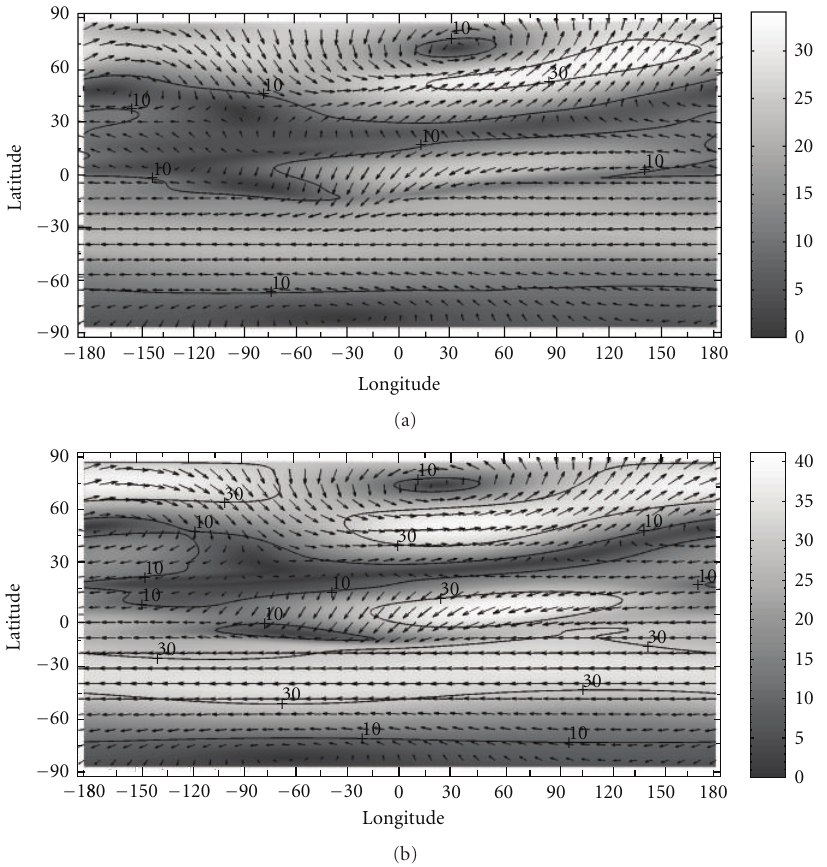
Figure 3: The global distributions of the vector of the simulated horizontal component of the neutral wind velocity at the altitude of 30km, obtained for 16 January and calculated for two distinct values of solar activity: F 10 . 7 = 101 (a) and F 10 . 7 = 230 (b). The velocities are given in